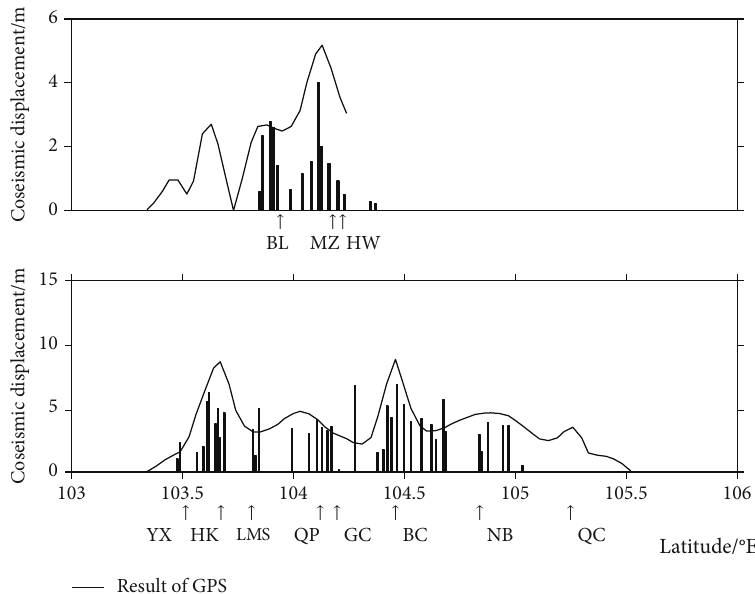
Figure 5: Comparison between observed coseismic displacement (vertical lines) and the slip of the subfaults near the surface area according to the inversion result (black curves). The top is the PGF, the bottom is the BCF.